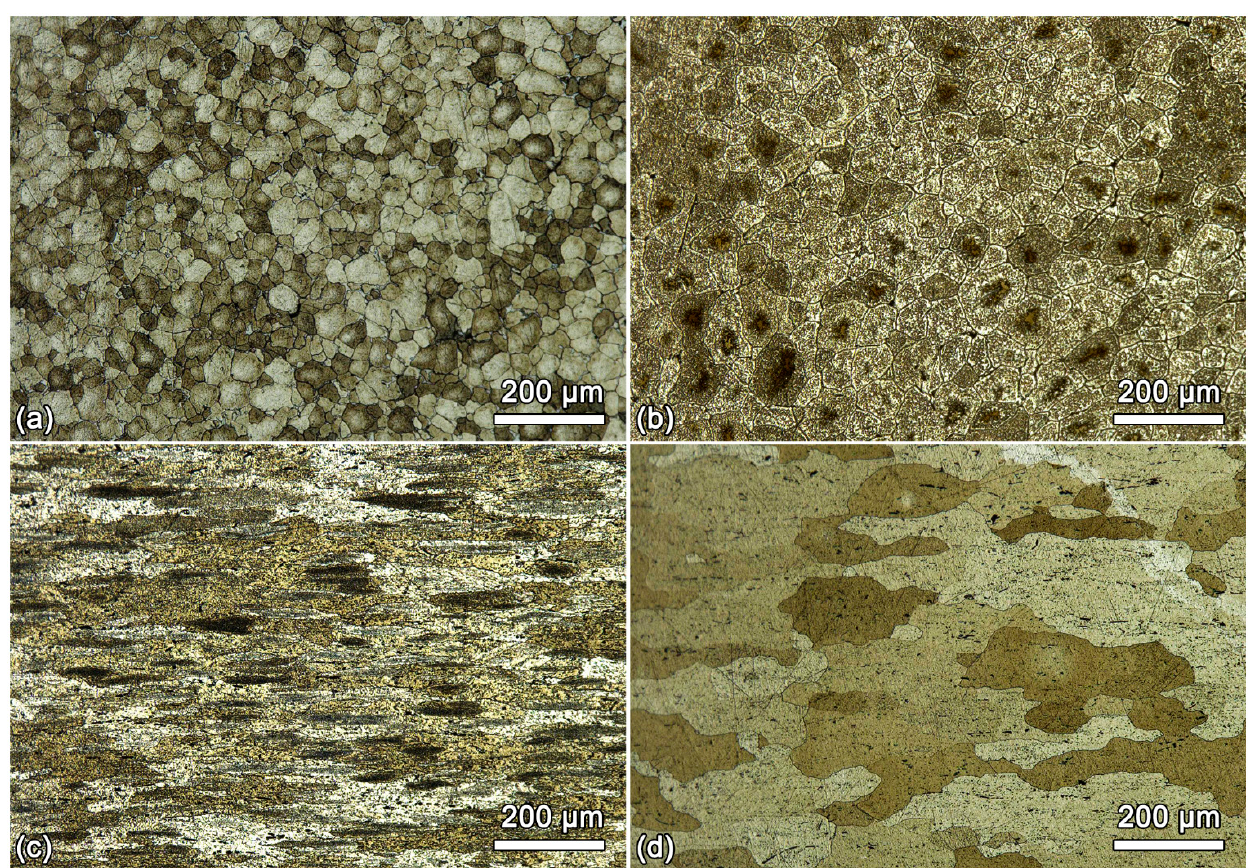
Figure 1. Microstructural investigations of each process of the Al–5.0Cu–0.50Mg–0.3Mn–0.17Ag commercial alloy: ( a ) as-cast, ( b ) homogenized, ( c ) hot-rolled, and ( d ) solutionized. This alloy is homogenized at 530 °C for 24 h, solution treated at 530 °C for 3 h, and aged at 160 °C for 24 h with the rolling processes.